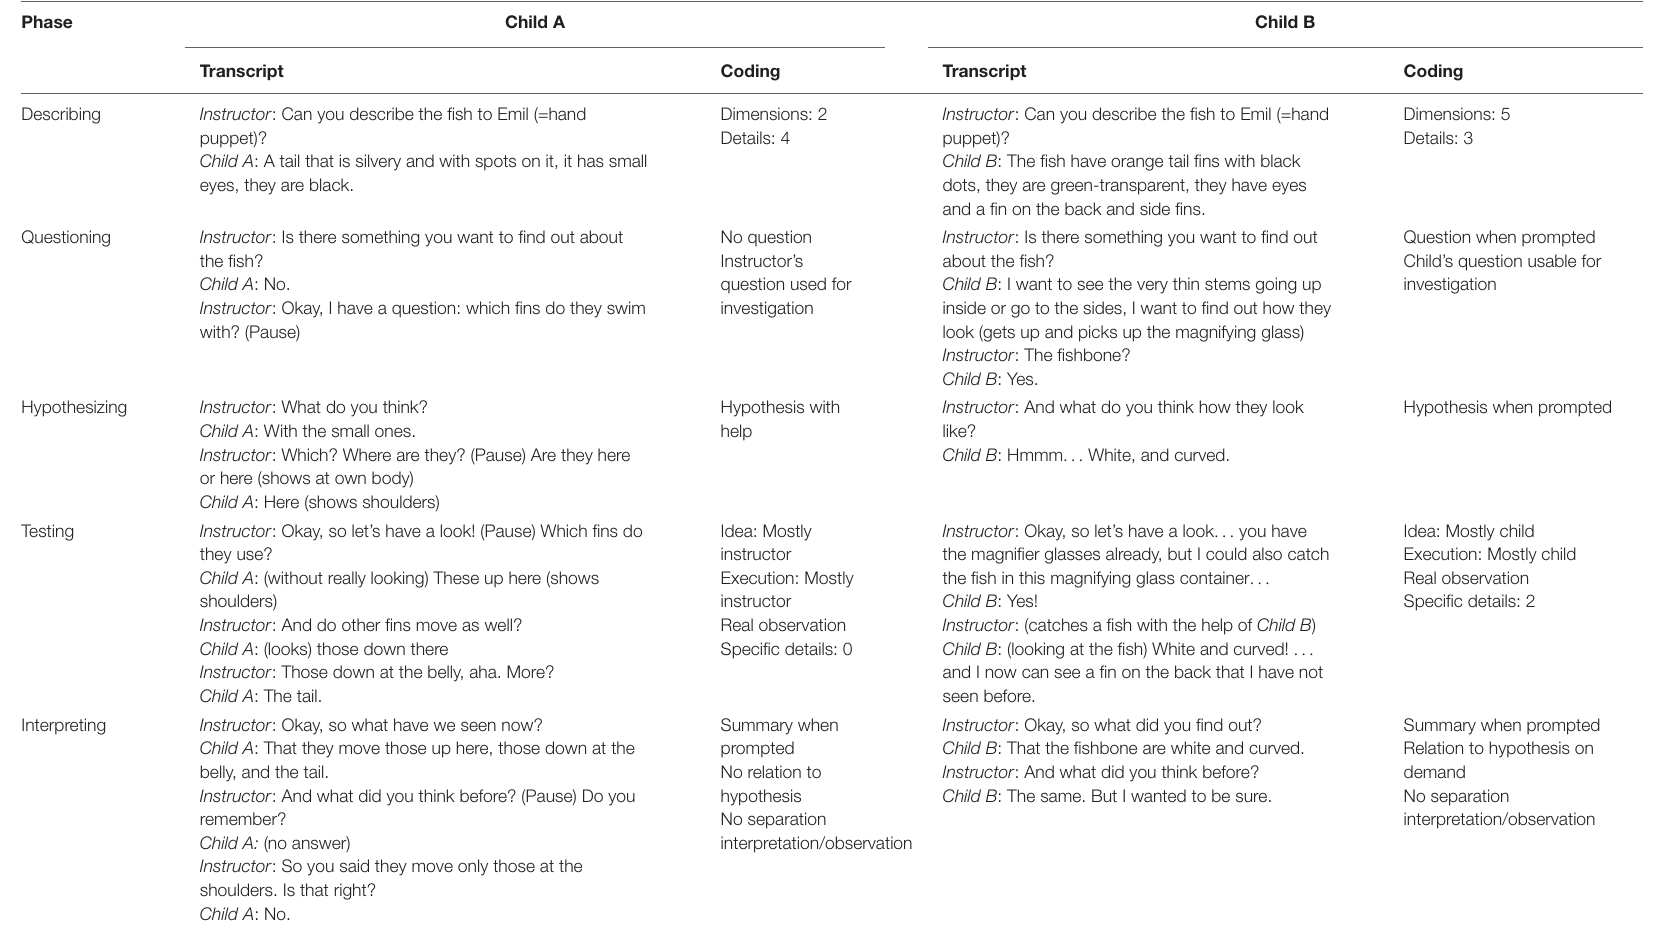
TABLE 1 | Examples of children’s behavior in the observation situation and coding. Phase Child A Transcript Coding Transcript